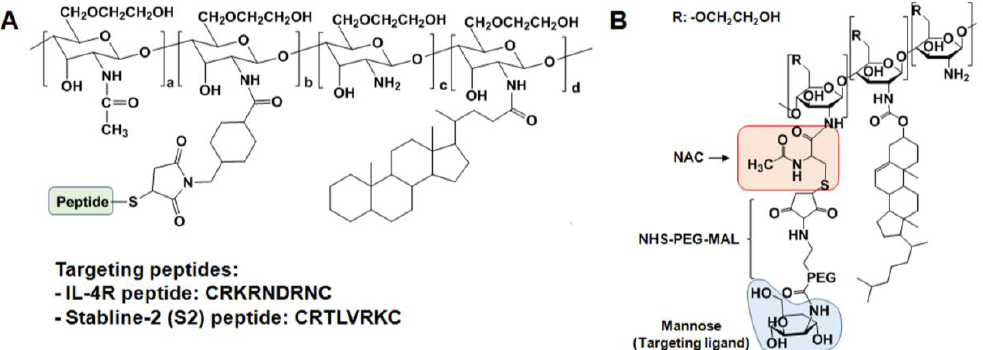
Figure 2. Specific receptor targetable GC derivatives. ( A ) Specific receptor targetable peptides such as IL-4R- and S2-peptide can be coupled to GC-CA 150 nanoparticles using SMCC as a crosslinker. ( B ) Chemical structure of macrophage mannose receptor-targeting nanoparticles (MMR). Macrophages are pivotal contributors to plaque destabilization through the release of various inflammatory precursors (e.g., proteases, ROS, and immune mediators) [56,57]. Therefore, they have emerged as key target biomarkers for high-risk coronary atheromata [58 – 60]. Recently, Kim et al. developed a macrophage mannose receptor (MMR)-targeted near-infrared fluorescence (NIRF) nanoprobe to specifically target macrophages in high-risk plaques (Figure 2B) [61]. The MMR-